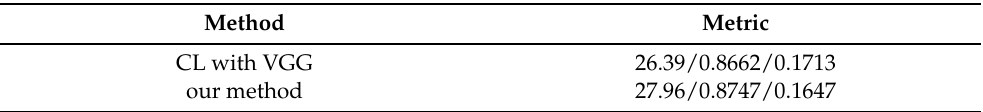
Table 7. Metric values (PSNR/SSIM/LPIPS) of the proposed PHMNet trained by the CL with different feature representation